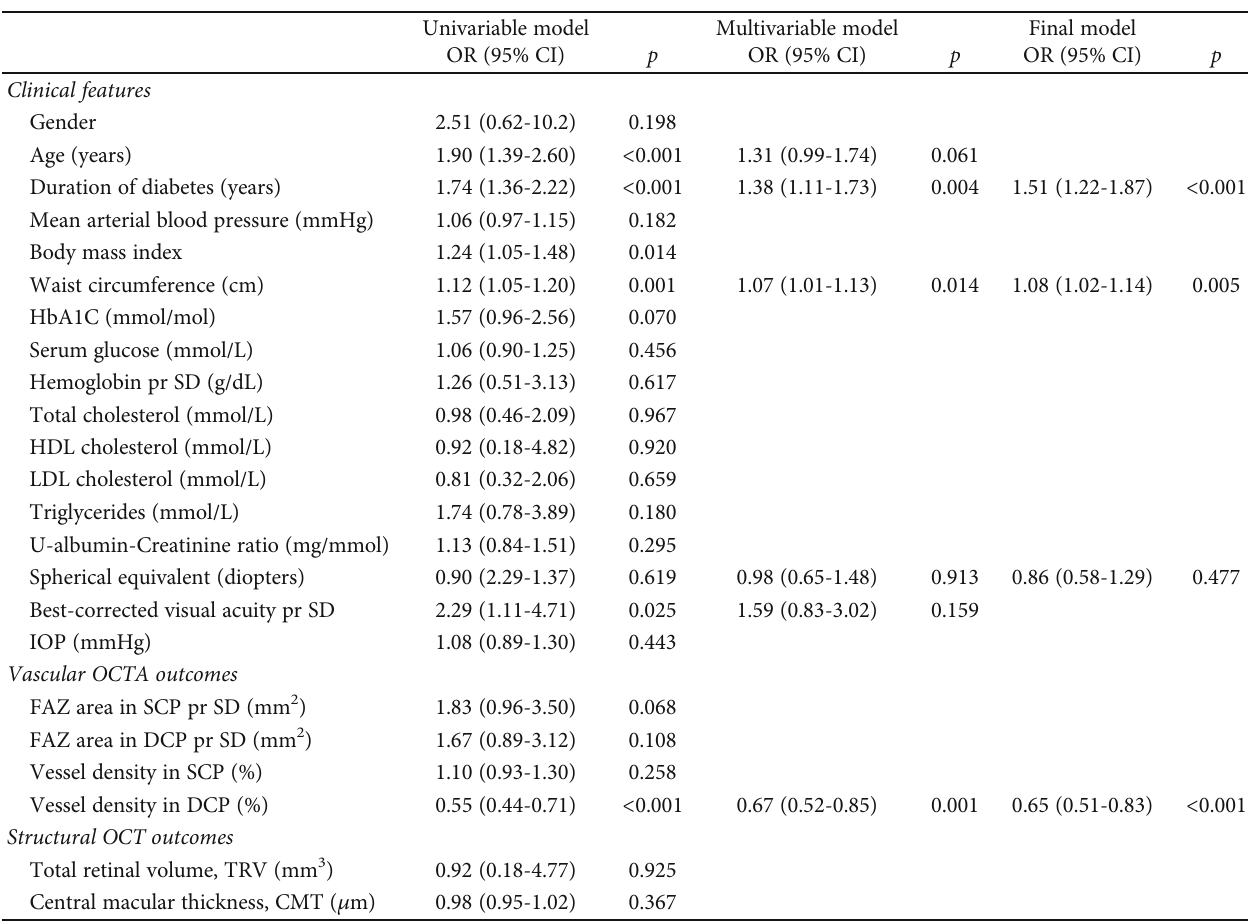
Table 4: The associations of clinical risk factors and OCTA parameters with the increasing level of NPDR calculated as odds ratios with ordered logistic regression